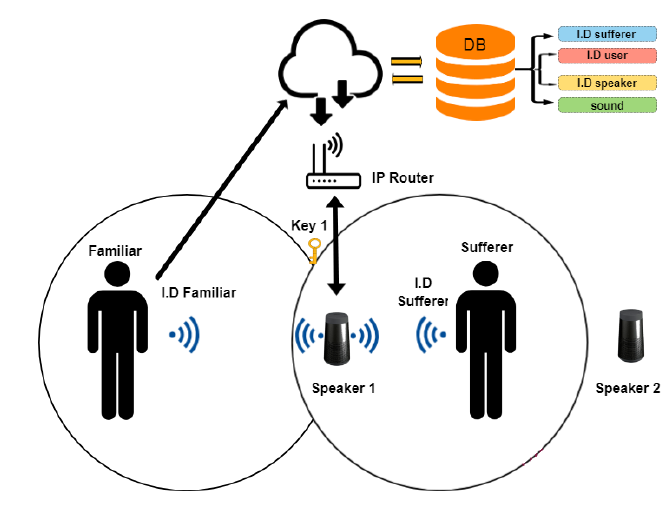
Figure 2. A representation of the system’s architecture at a user-communication level.